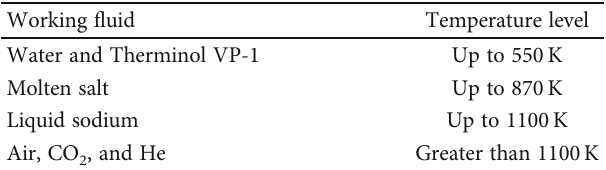
Table 1: Temperature range for working fl uids